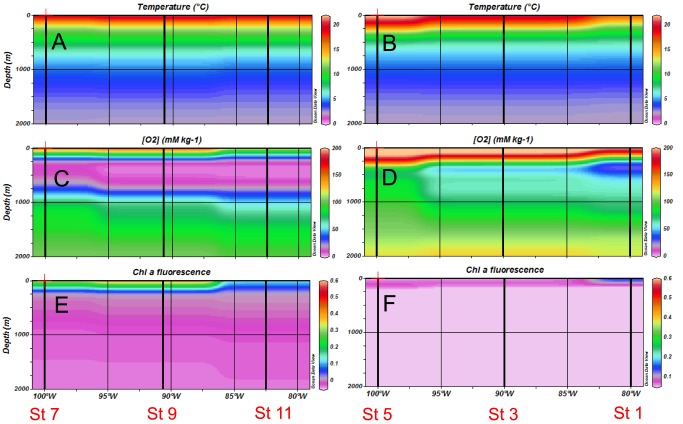
Horizontal and vertical distributions of hydrological and biogeochemical parameters during the 2010 cruise (R/V Atlantis).(A, B) temperature, (C, D) dissolved oxygen, (E, F) chlorophyll fluorescence in the northern transect (left panels) and southern transect (right panels).